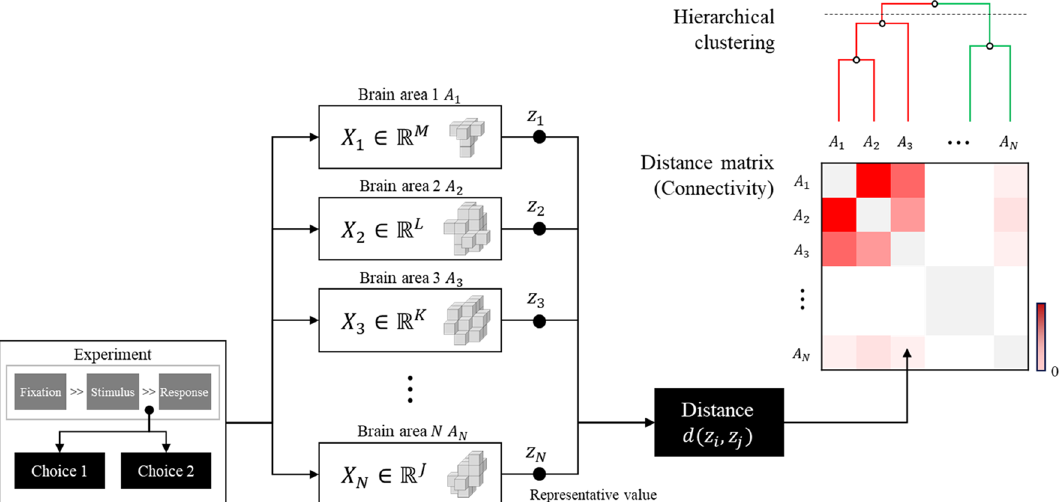
Figure 2. Hierarchical clustering to partition the brain activity pattern during the experimental task. Suppose there are N brain regions of interests. We can extract brain activation patterns X i during evaluation process for each brain regions. Because each brain regions A i has its own shape and voxel size, however, the voxel intensity itself cannot be compared between brain regions. Hence, representative values (e.g., mean intensity or eigenimage) z i for each sample and brain regions were extracted. The distance (or dissimilarity) d ( z i , z j ) between each brain regions to create a distance matrix. Hierarchical clustering can then be performed using a distance matrix. Note that Pearson’s correlation distance was used as a distance metric in our analysis.